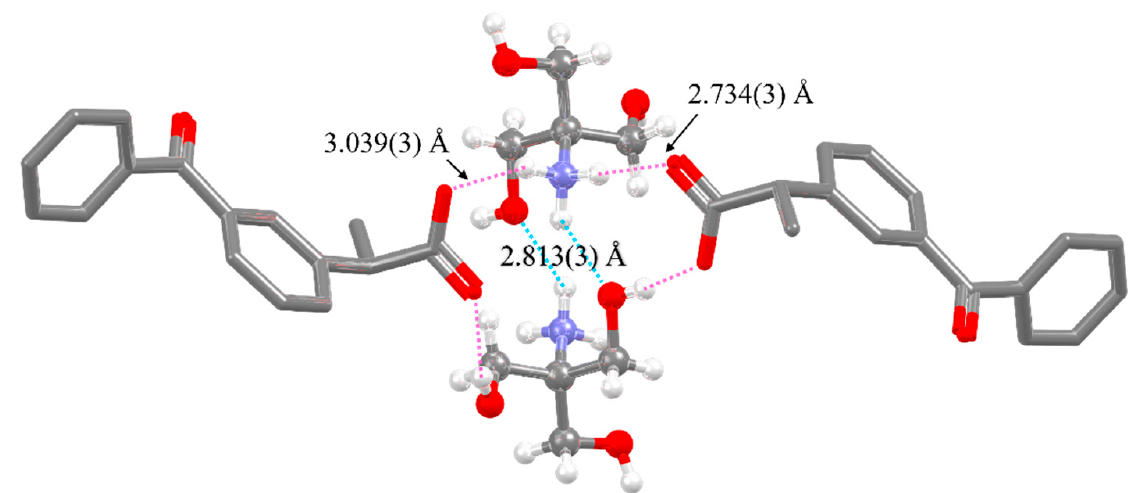
Figure 6. Hydrogen bond among ketoprofen and tromethamine molecules. N-H…O bonds are accompanied by values of the N…O distance.